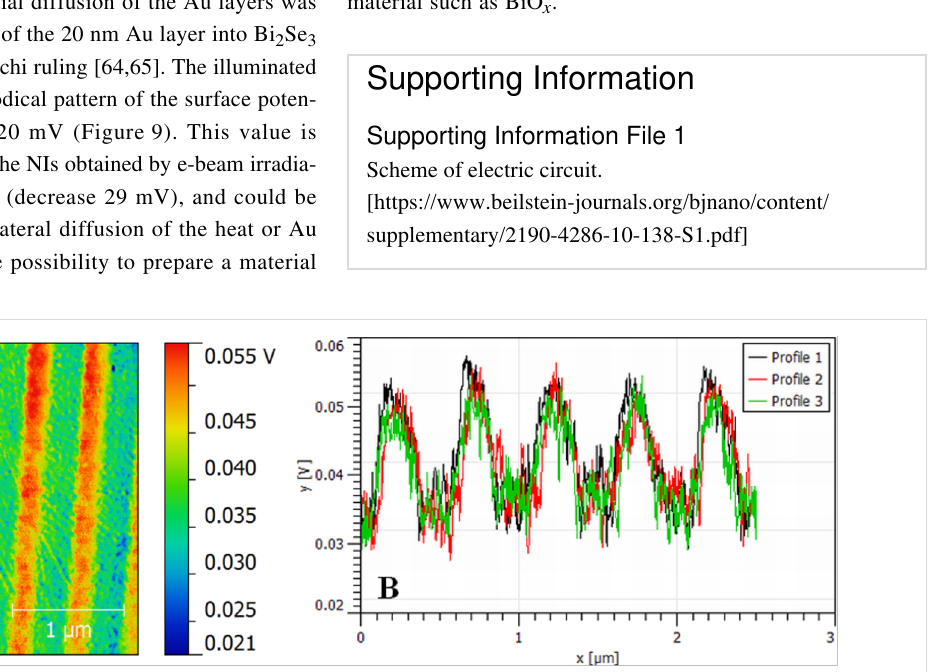
Figure 9: (A) Changes of the surface potential in the pattern after UV photodiffusion of Au (20 nm) into Bi 2 Se 3 and (B) three line profiles.